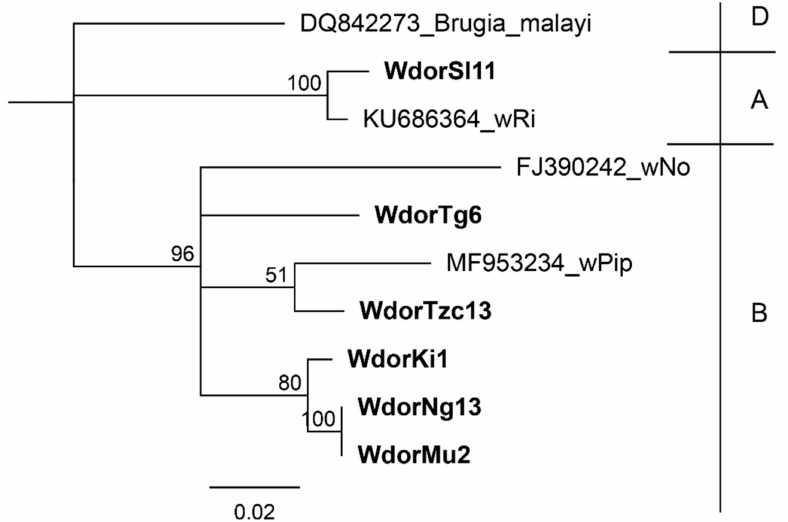
Figure 2. Neighbour joining tree based on the cytochrome c oxidase subunit I( coxA ) gene sequences from this study. The detected Wolbachia are denoted by W followed by the host denoted as dor ( B. dorsalis ), population (Tg-Togo, Tzc-Tanzania, Ki-Kitui, Sl-Sri Lanka, Ng-Nguruman and Mu-Muranga) and population sample ID. Bootstrap values are indicated above branches. Branches with bootstrap support lower than 50% are